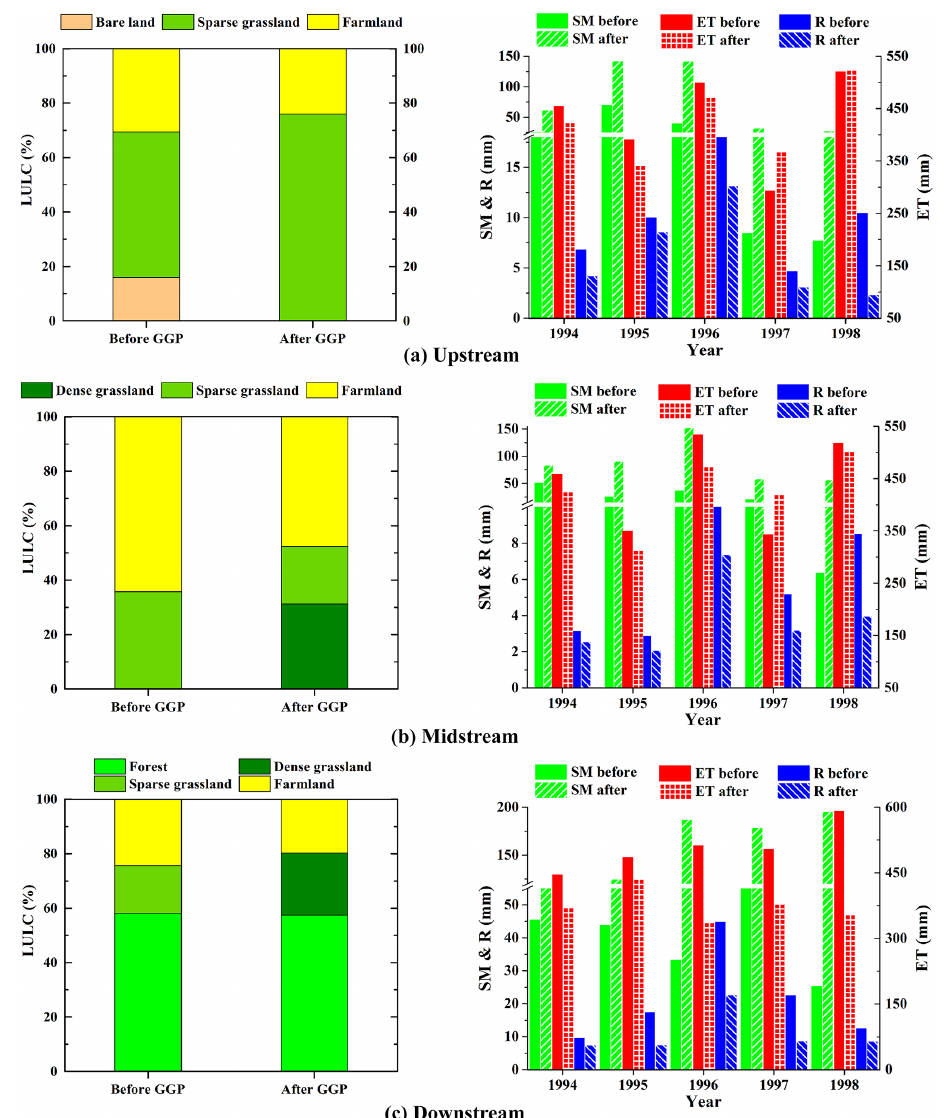
Figure 10. Impact of LULC changes on surface runoff in selected sub-basins distributed in the upstream, midstream, and downstream areas of the basin. The left column shows the land use types and corresponding ratios, and the right column shows the simulated changes of the soil moisture content (SM), evapotranspiration (ET), and surface runoff ( R ) before and after the GGP scenarios while holding climate